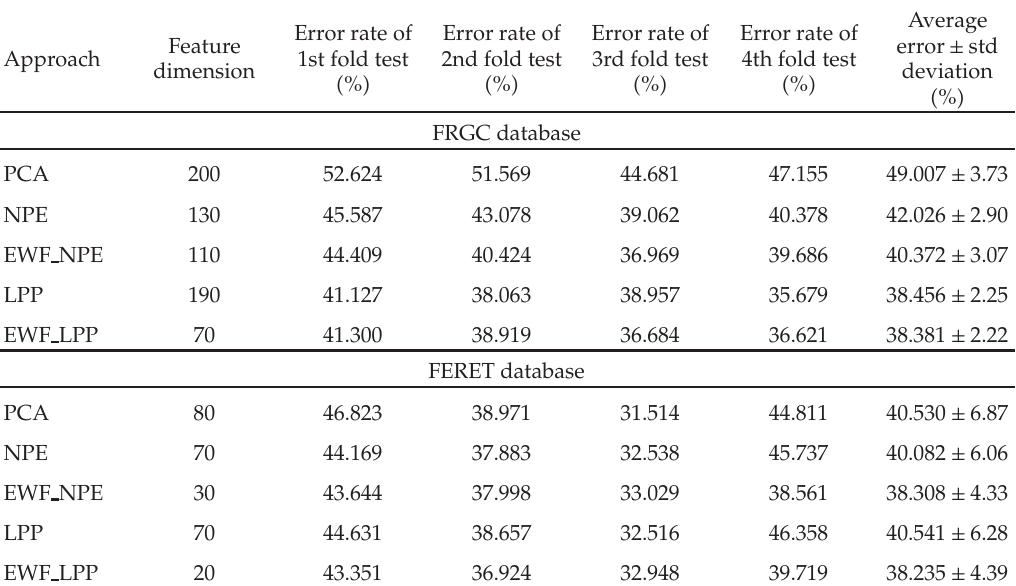
Table 3: Performance comparison in terms of average error